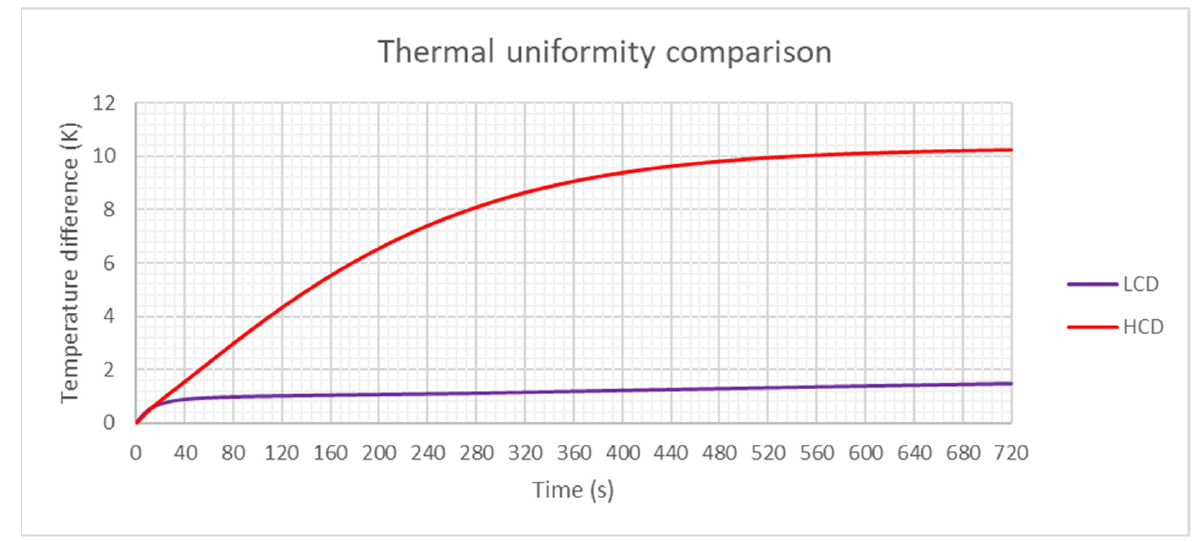
Figure 20. Cell temperature difference comparison–LCD & HCD.